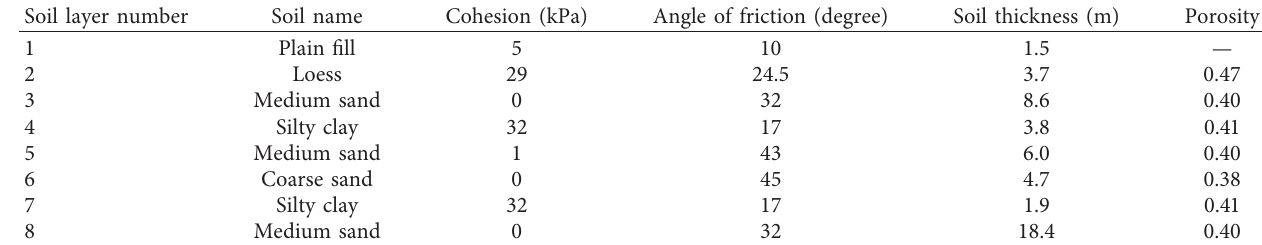
Table 1: The physical parameters of the soil layer.